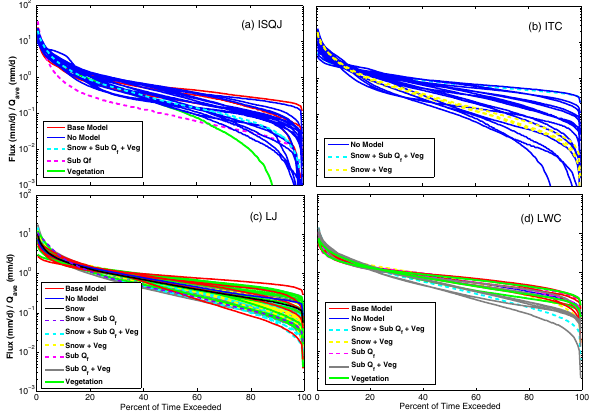
Fig. 5. FDCs for total streamflow within the 4 main dominant model process classes, grouped by catchment class. (L, I, and X denote low to high seasonality in P , while V, H, T, S, and A denote low to high aridity). Table 1. Entropy reduction in dominant model processes sorted by